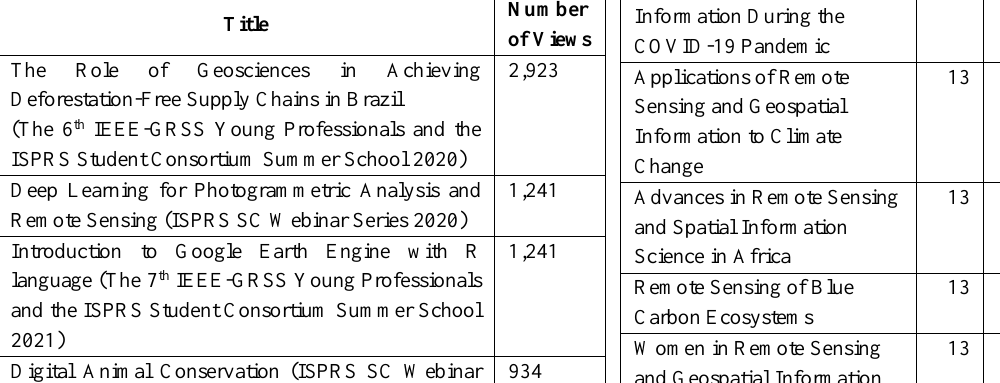
Table 1. The top five most popular videos in the ISPRS SC’s YouTube channel as of March 2022.